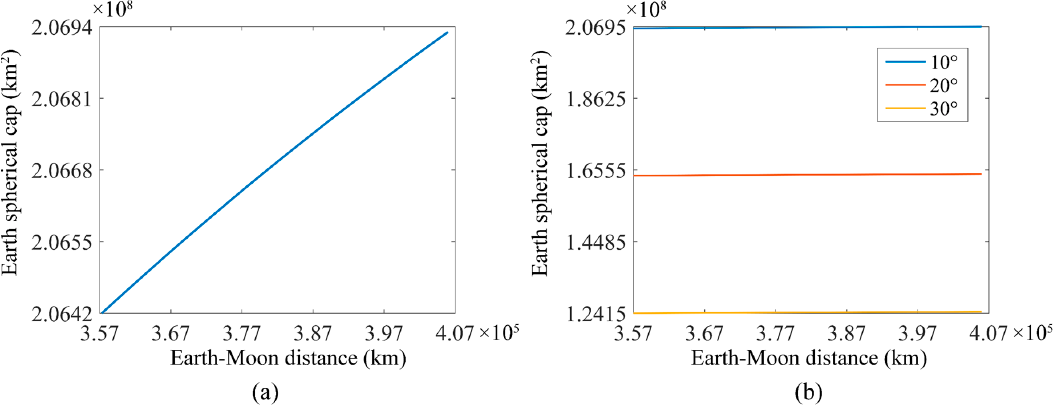
Figure 6. Influences of Earth–Moon distance on the Earth spherical cap ( a ) minimum Earth observation elevation angle is 10°, ( b ) minimum Earth observation elevation angle is 10°, 20°, 30°.